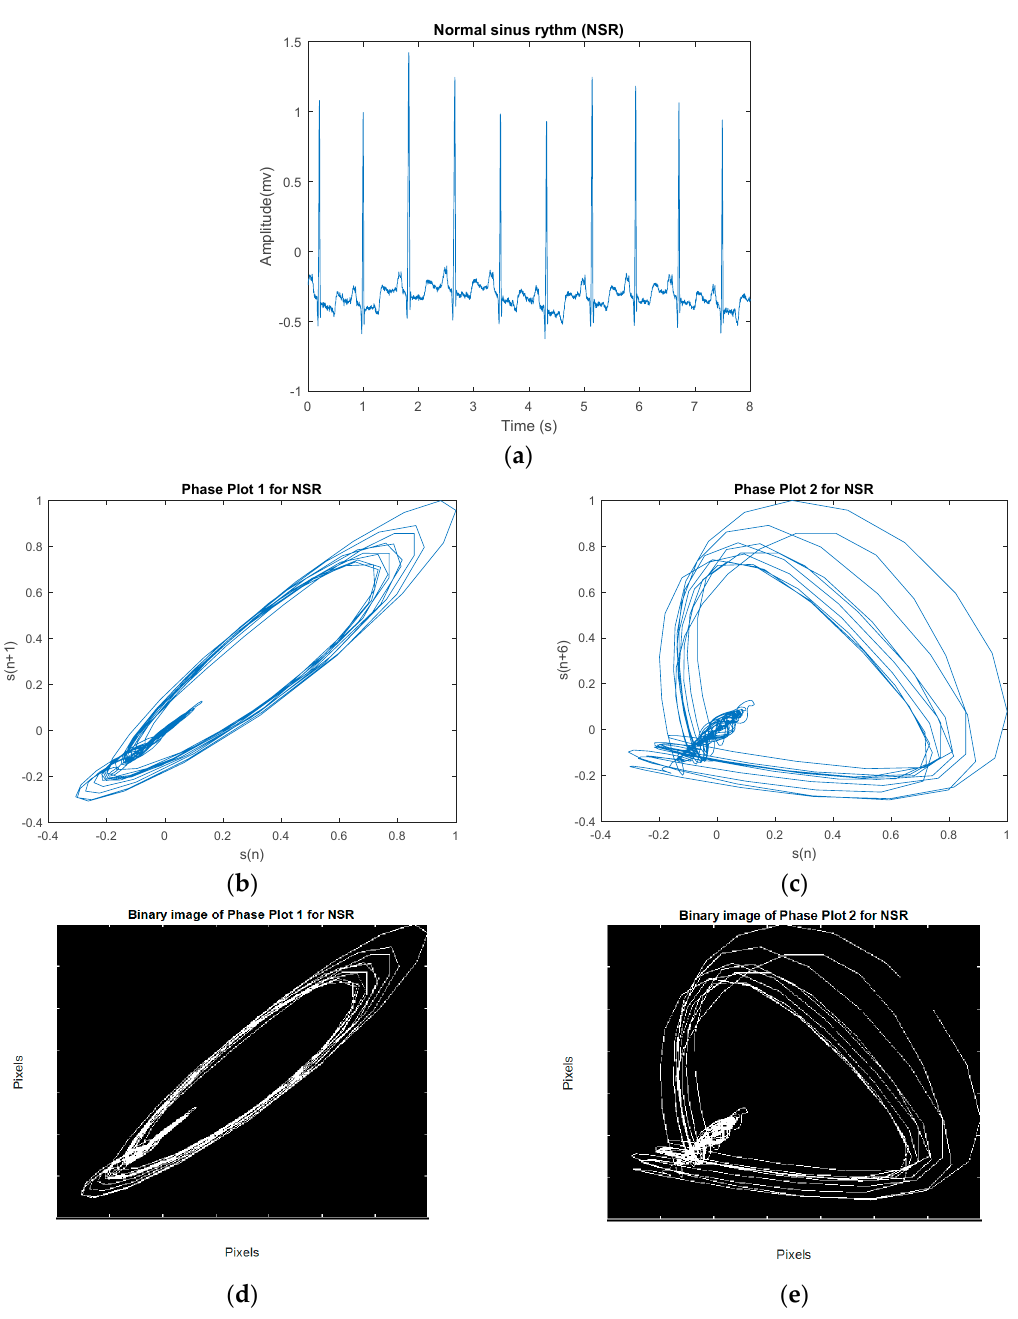
Figure 3. ( a ) An example NSR segment. ( b ) Phase plot of segment with a 1-sample lag. ( c ) Phase plot of segment with a 5-sample lag. ( d ) Related binary image of (b). ( e ) Related binary image of ( c ).